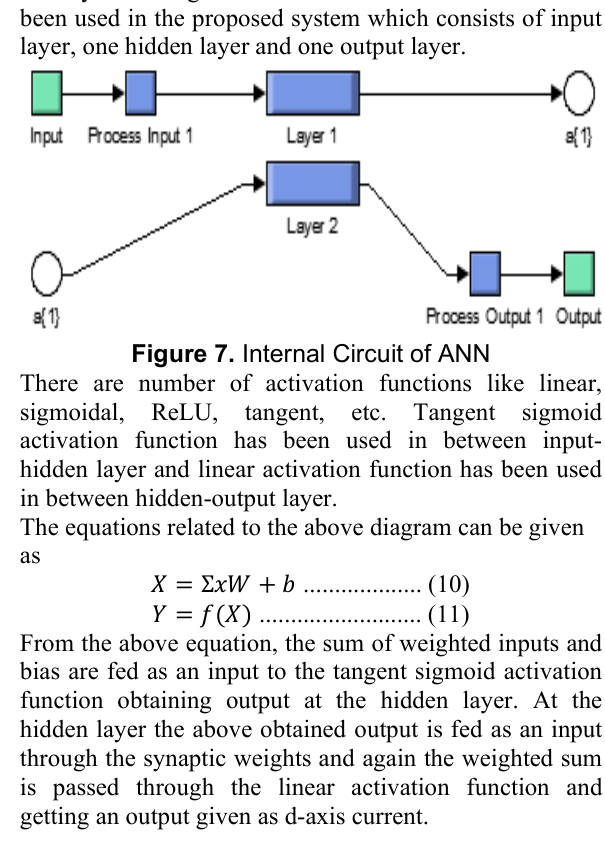
Figure 8. Model Predictive Control based DC link voltage